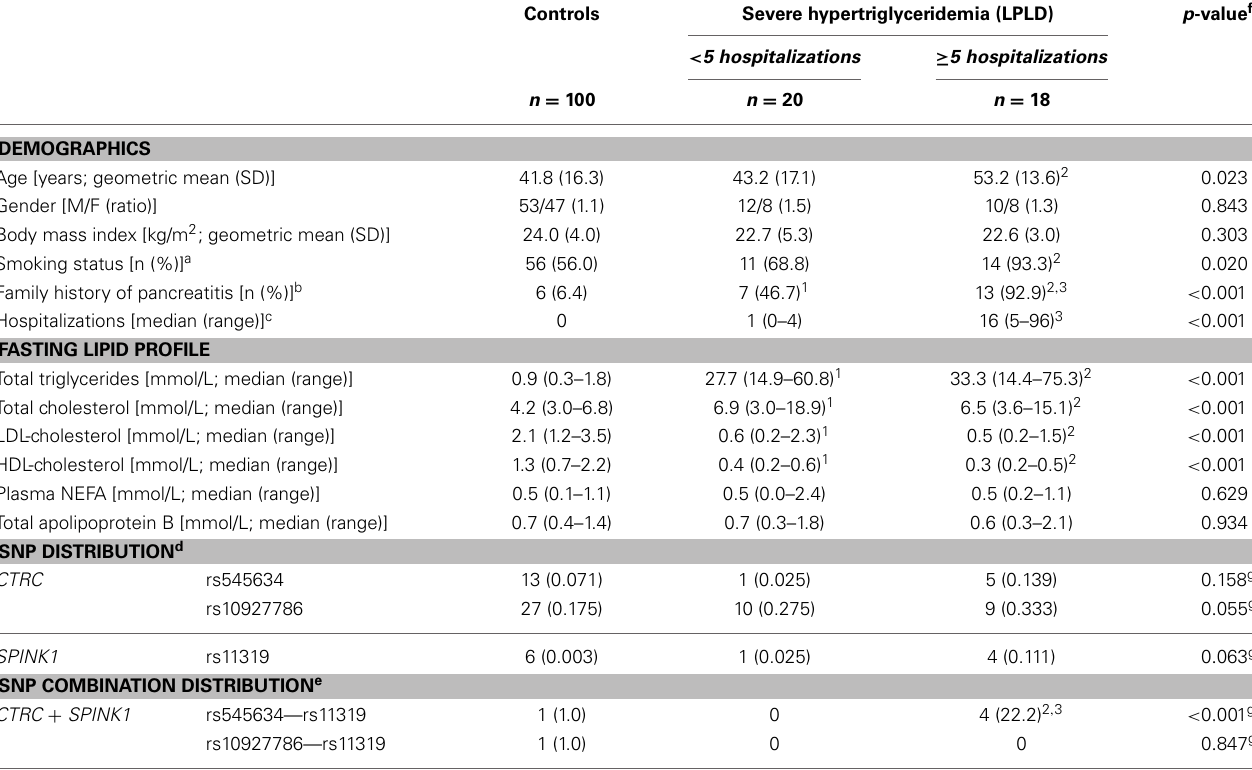
Table 1 | Characteristics of the Participants.